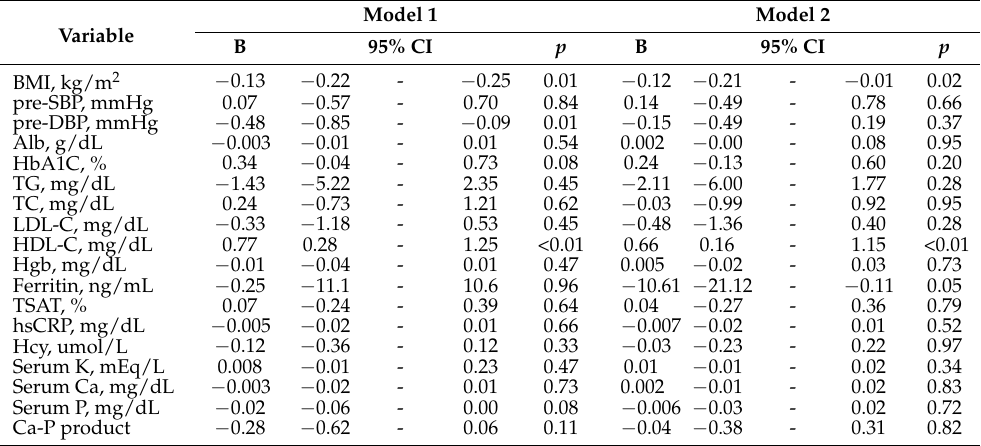
Table 2. Association between the h/H and CVD risk factors during the experiment in HD